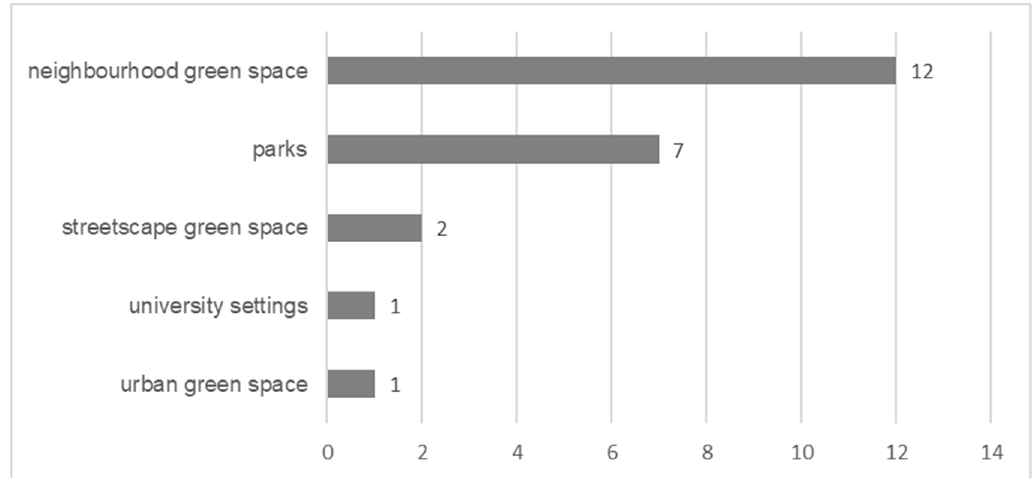
Figure 2. Type of studied green space.